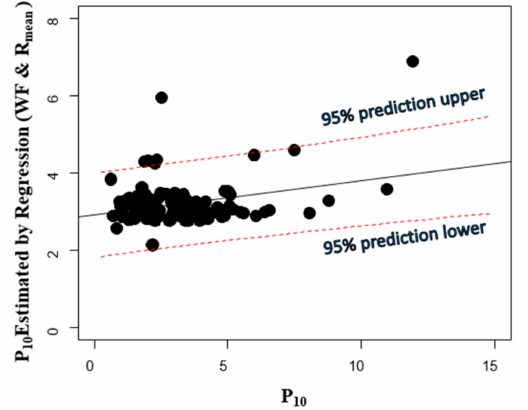
Figure 8. Estimated P 10 by multiple regression